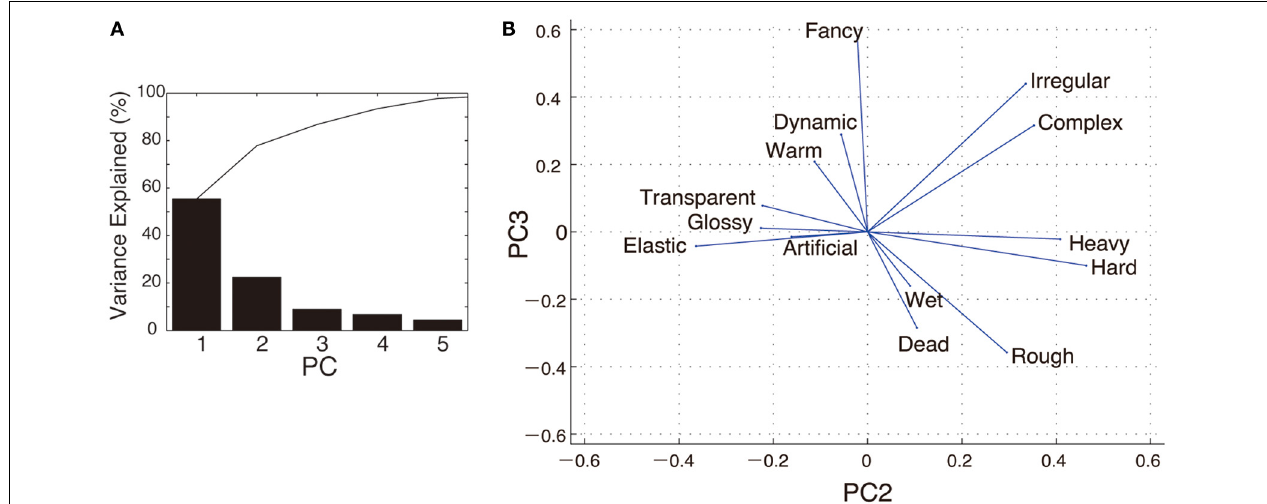
FIGURE 3 | PCA for the impressions of material images. (A) Scree plot of the PCA. Each bar shows the variance of rating data explained by each PC (PC1–PC5). The line chart indicates the cumulative variance of the data explained by PCs from PC1 to up to PC5. (B) The